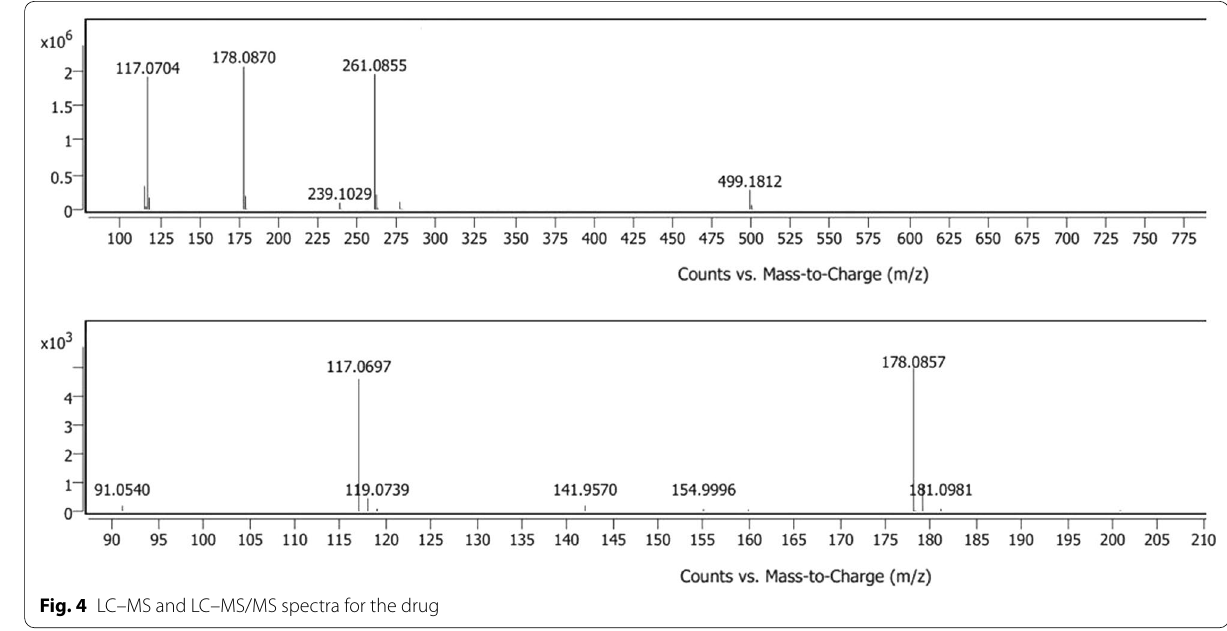
Fig. 4 LC–MS and LC–MS/MS spectra for the drug